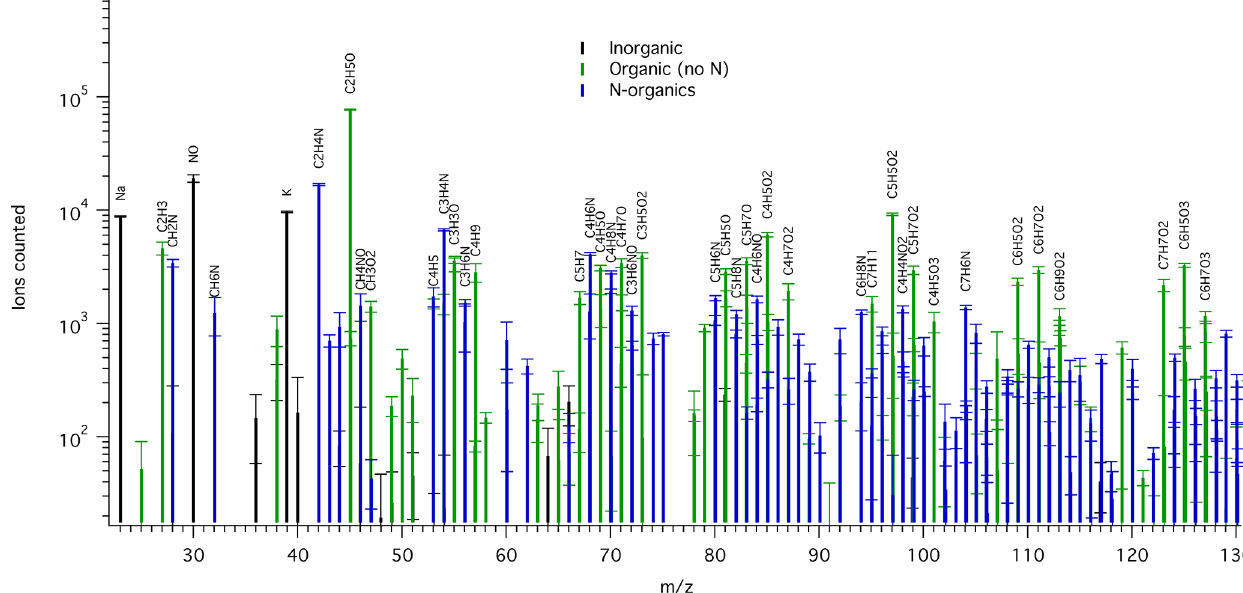
Figure 1. Example mass spectrum of background-corrected TDCIMS-derived positive ion signals for an ambient submicron aerosol sample collected from 15:15UTC on 26 May to 09:00UTC on 27 May 2016. Ion types are color-coded: inorganic (black), organic with no N (green), and N-containing organics (blue). All labeled organic ion compositions can be assumed to include an H + adduct. Only a subset of the mass range is shown for clarity. Peaks of over 2000 ion counts are labeled, except when overlapping with a higher peak. The square root of counted ions is plotted as error bars.